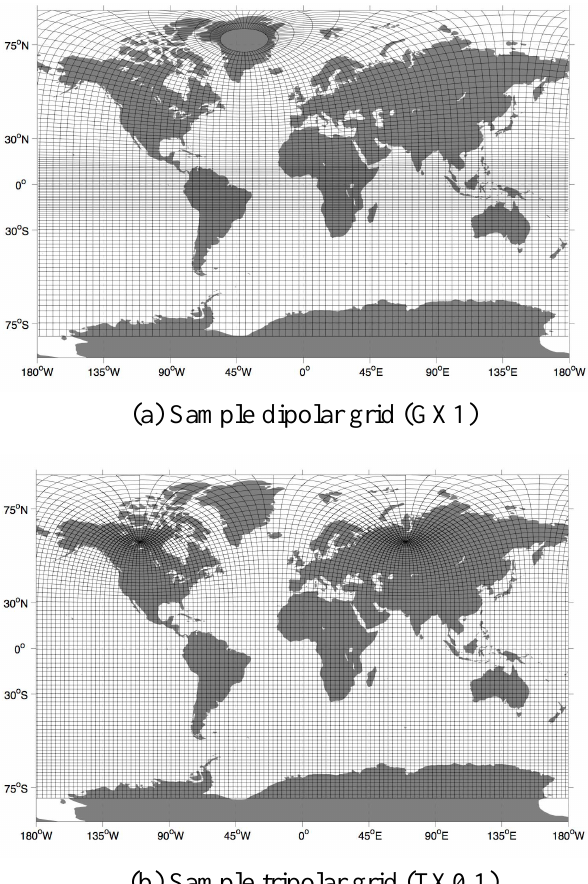
9. The grid can support high-resolution and multi-scale